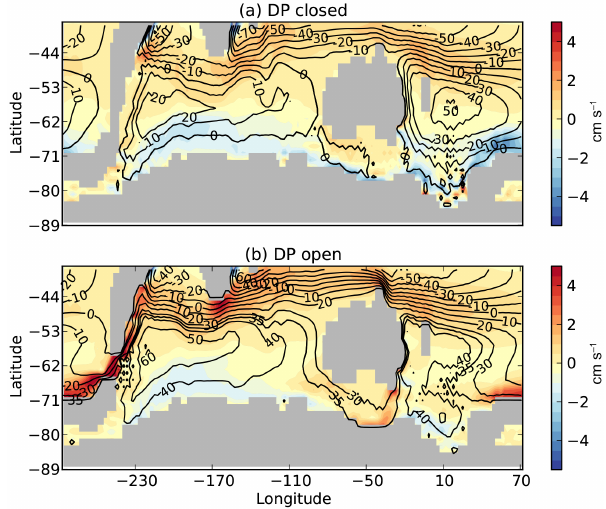
Figure 4. Annual and vertical average of zonal velocity (cms − 1 ; positive values indicate eastward flow) with ocean horizontal stream function (Sverdrup; 1Sv is 10 6 m 3 s − 1 ) overlaid. The Tasman Gate- way is open, with (a) the Drake Passage (DP) closed and (b) the DP open (shallow at around 350m depth). Contour intervals have been adjusted in (a) to elucidate the flow through the